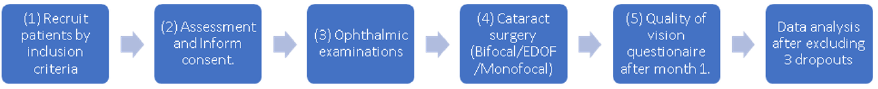
Figure 2. Guidelines flow diagram for quality of vision analysis.